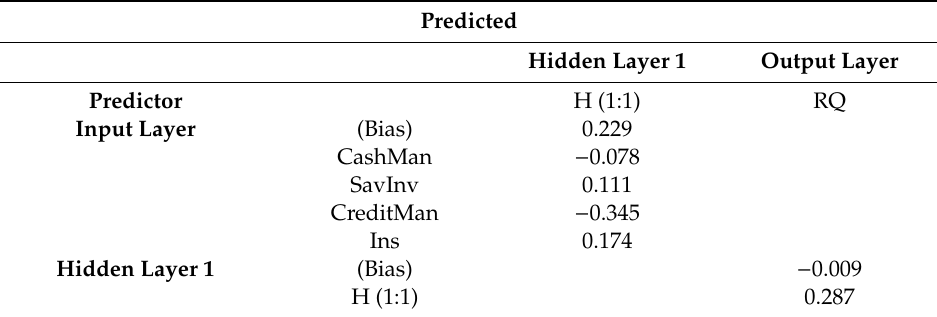
Table 2. Parameter estimates for Model A (calculated by the authors) .